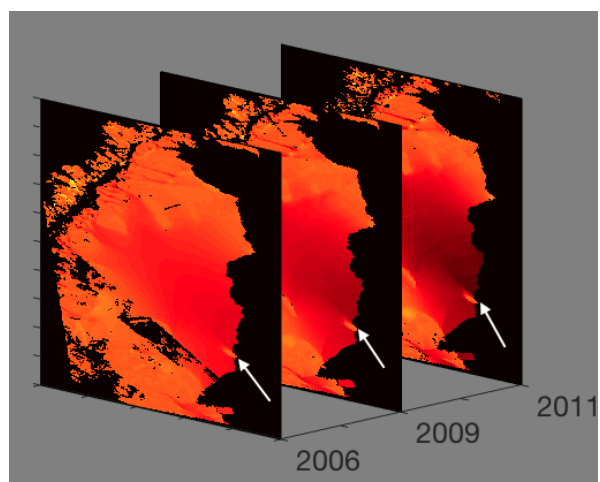
Figure 3. Ice surface velocity. The figure shows the data set for 3 different years around the beginning of the Larsen C ice crack in 2010. The data from the years 2007, 2008 and 2010 are corrupted on the region of interest, and they are excluded. The color scale indicates the magnitude of the velocity from light red (low velocity) to dark red (high velocity), and the arrow points to the starting tip of the crack. The result of the directed partitioning is shown in Fig. 4. Data sourced from Rignot et al.